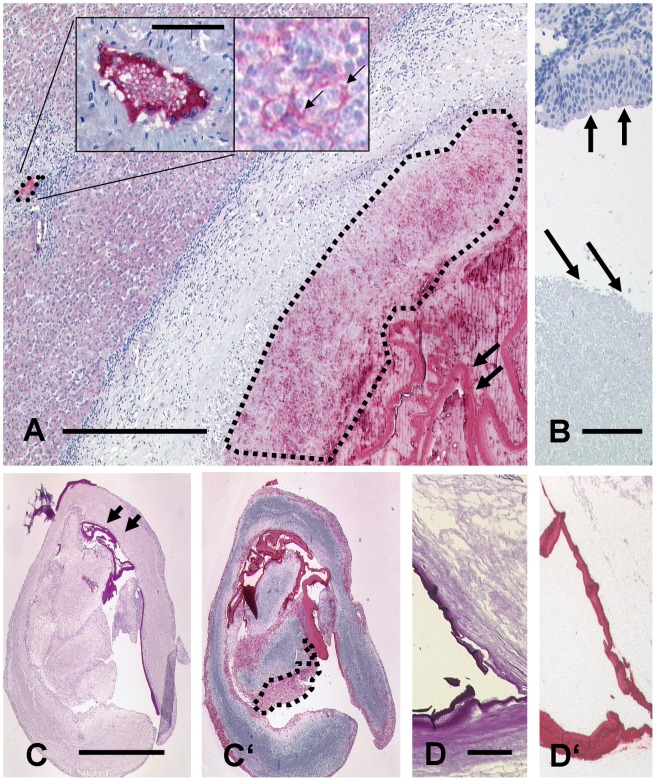
Immunohistochemical staining modalities of the monoclonal antibody (mAb) Em2G11 for metacestodes of Echinococcus multilocularis.
Figure 2A:
E. multilocularis lesion in human liver tissue. The antigen is detected in the laminated layer (two arrows, right) and in the necrotic area around the lesion (dashed lined area, right). The antibody detects small particles of E. multilocularis (spems) up two 1.5 mm away from the main lesion in a small liver vessel (small area marked with a dashed line on the left). Insert left highlights this lesion at a higher magnification showing a specific staining of spems. Insert right shows specific staining in lymphoid tissue of a regional lymph node on the surface of cells (arrows; bar =  750 µm; bar insert =  40 µm). B: In contrast, no staining is observed in caseous necrosis of tuberculosis (arrows low) and in bronchial epithelial tissue (arrows high; bar =  50 µm). C: Serial section of an aspirate from the liver. C shows a PAS staining of a strongly positive laminated layer. C′: Staining of the section with mAb Em2G11 reveals a strong positivity of the laminated layer and of the necrotic tissue with spems (dashed lined area; bar =  500 µm). D: PAS staining of brain tissue showing the laminated layer of an E. multilocularis metacestode. D′: The laminated layer is strongly positive for mAb Em2G11 even after 60 years of formalin fixation (bar =  50 µm).